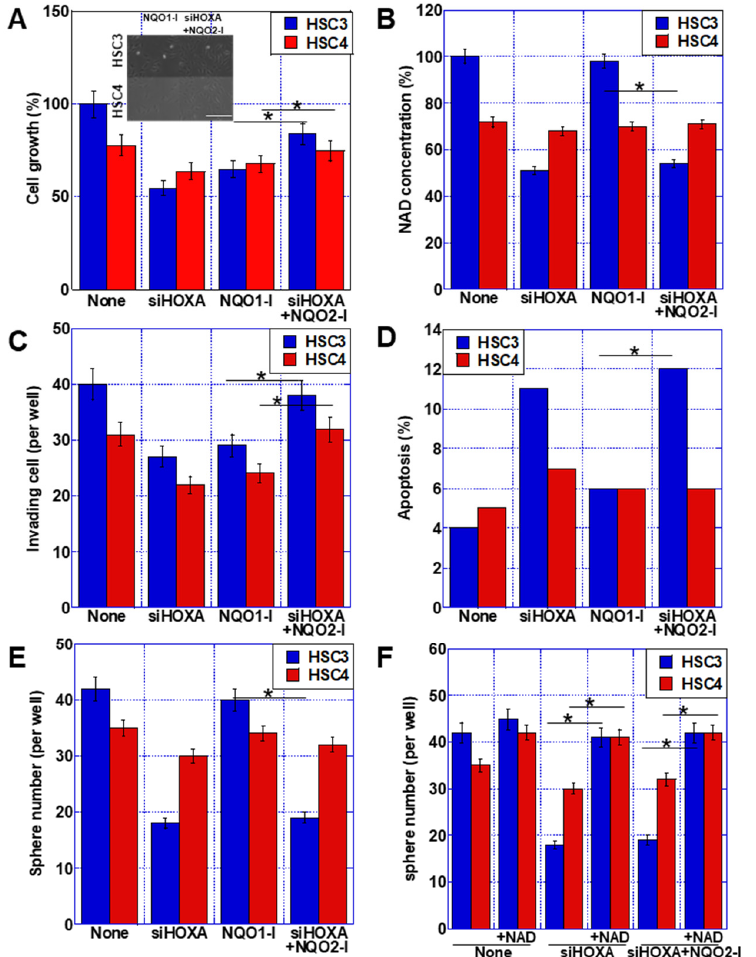
Figure 5. Differential roles of NQO1 and NQO2 in OSCC cells. To compare the roles of NQO1 and NQO2 in malignant phenotypes, cells were treated with siHOXA, NQO1-I (1 nM), or siHOXA+NQO2-I (15 nM) for 48 h. ( A – E ) Effects of these treatments on cell growth ( A ), NAD concentration ( B ), invasion ( C ), apoptosis ( D ), and sphere formation ( E ). (Inset in ( A )) Cell morphology. Scale bar, 50 μ m. ( F ) The effect of NAD on sphere formation. Error bars indicate the